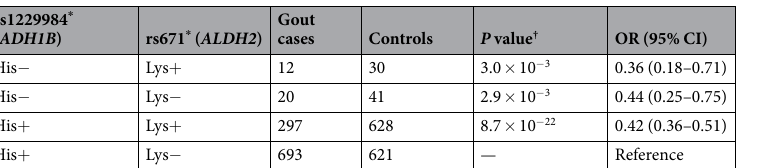
— Reference Table 4. Gout risk due to combination of ADH1B and ALDH2 genotypes. Abbreviations: His = histidine; Lys = lysine; OR = odds ratio; CI = confidence interval. * In the analysis of rs1229984 (His48Arg), “His + ” and “His − “ mean His carrier (His/His or His/Arg) and non-His carrier (Arg/Arg), respectively. In the analysis of rs671 (Glu504Lys), “Lys + ” and “Lys − ” mean Lys carrier (Lys/Lys or Lys/Glu) and non-Lys carrier (Glu/Glu), respectively. We investigated the combined effects of rs1229984 and rs671 on gout as compared with “His + / Lys − ”. † The P value was calculated using logistic regression